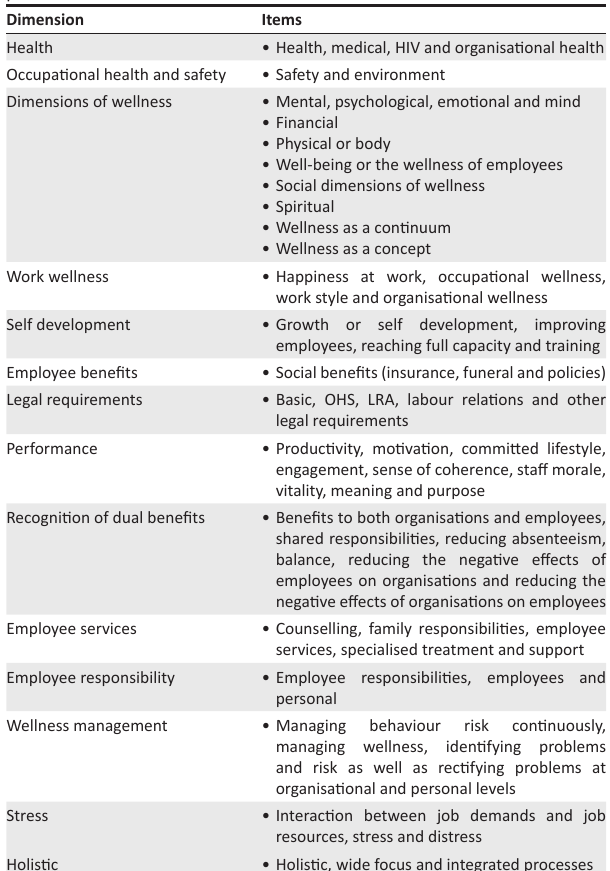
TABLE 3: Definitions of employee wellness according to participating labour